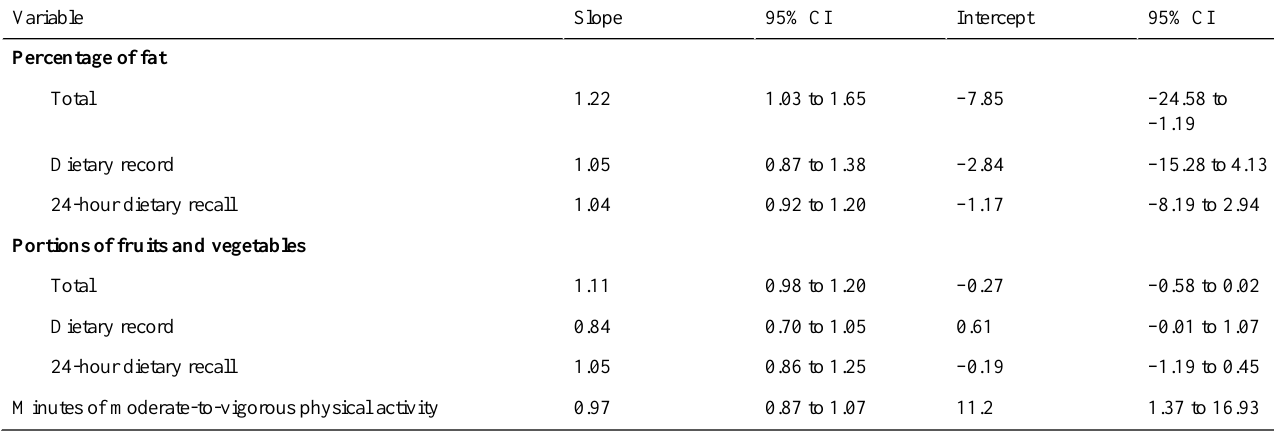
Table 4. Passing-Bablok regression variables of the Energy Balance on Cancer (BENECA) mHealth system versus the 24-hour dietary recall, dietary records, and